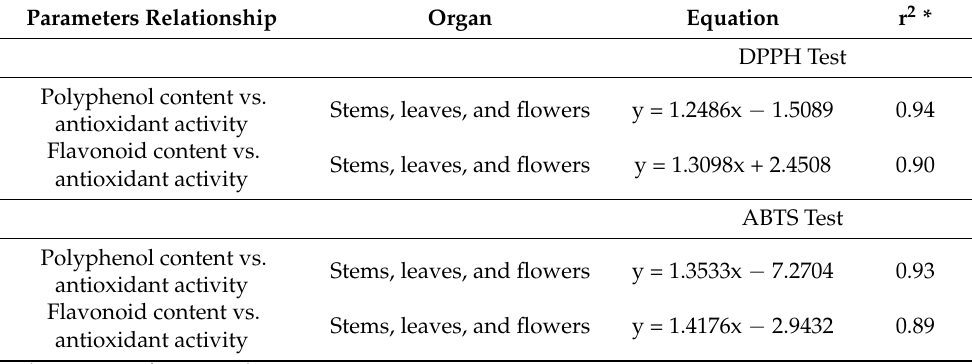
Table 12. Correlation between antioxidant activities and total phenol and flavonoid contents of Cladanthus mixtus